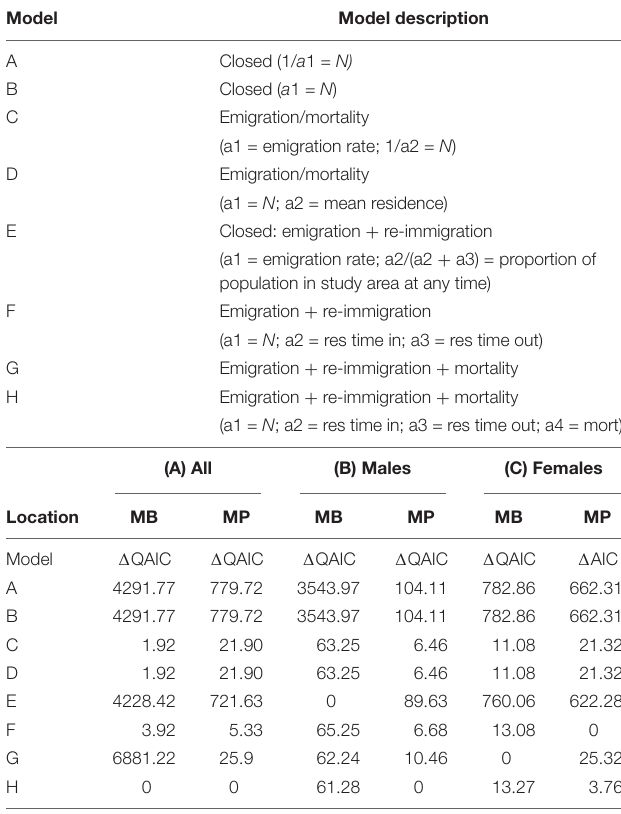
TABLE 1 | Model parameters, fits ( (cid:49) QAIC) and comparison for the Lagged Identification Rate (LIR) of (A) all manta rays, (B) males and (C) females at Manta Bay (MB) and Manta Point (MP) in the Nusa Penida MPA, Indonesia.